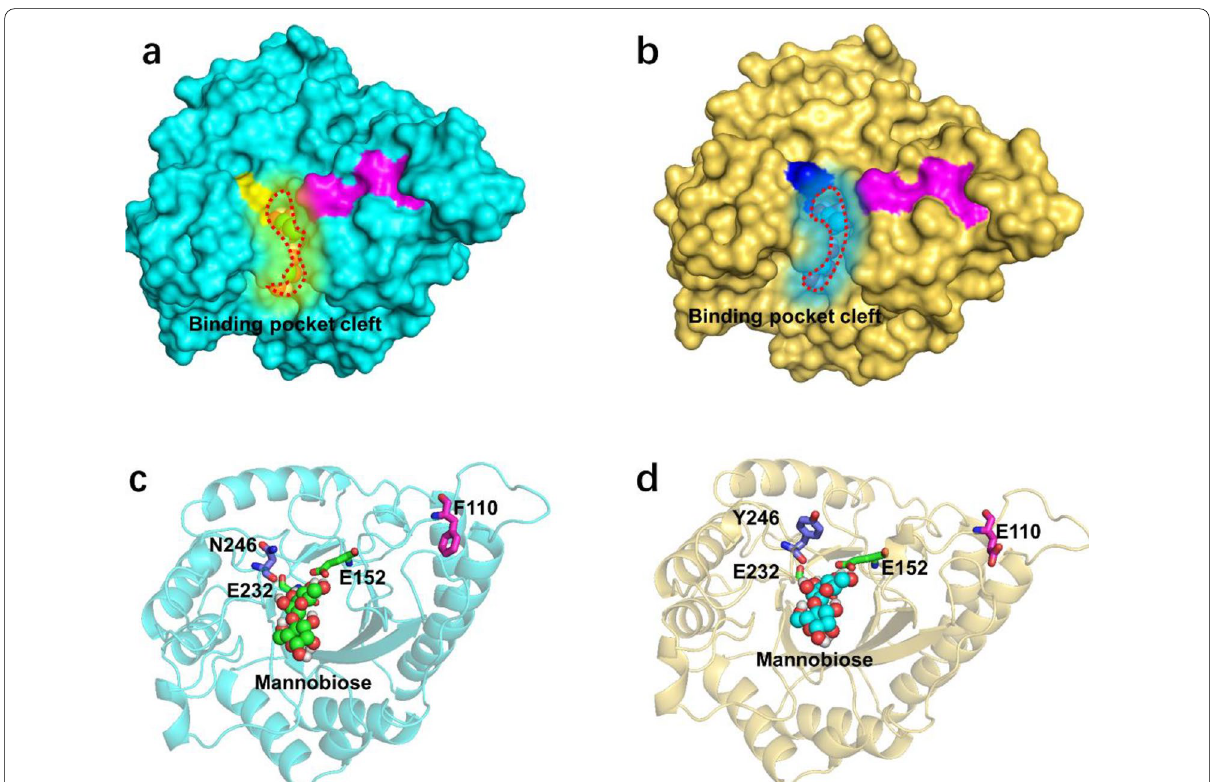
Fig. 6 Binding modes and surface representation of the substrate in PcMan113‑WT and PcMT3. The structures were obtained from cluster analysis of the MD trajectories during 30 ns of simulation. Surface representation of PcMan113‑WT in color cyan ( a ) and PcMT3 in yellow ( b ) in complex with substrate mannobiose. The protein–substrate complex cartoon surface representation of PcMan113‑WT in color cyan ( c ) and PcMT3 in yellow ( d ). The substrate‑binding channel surface was shown with red cycles in light yellow shadow (WT) and blue shadow (PcMT3). Site N246 is shown as a yellow surface and light blue sticks (( a ) and ( c )), site Y246 is shown as a blue surface and sticks (( b ) and ( d )), site F110 and E110 are shown as a magenta surface and sticks. The substrate is presented as green